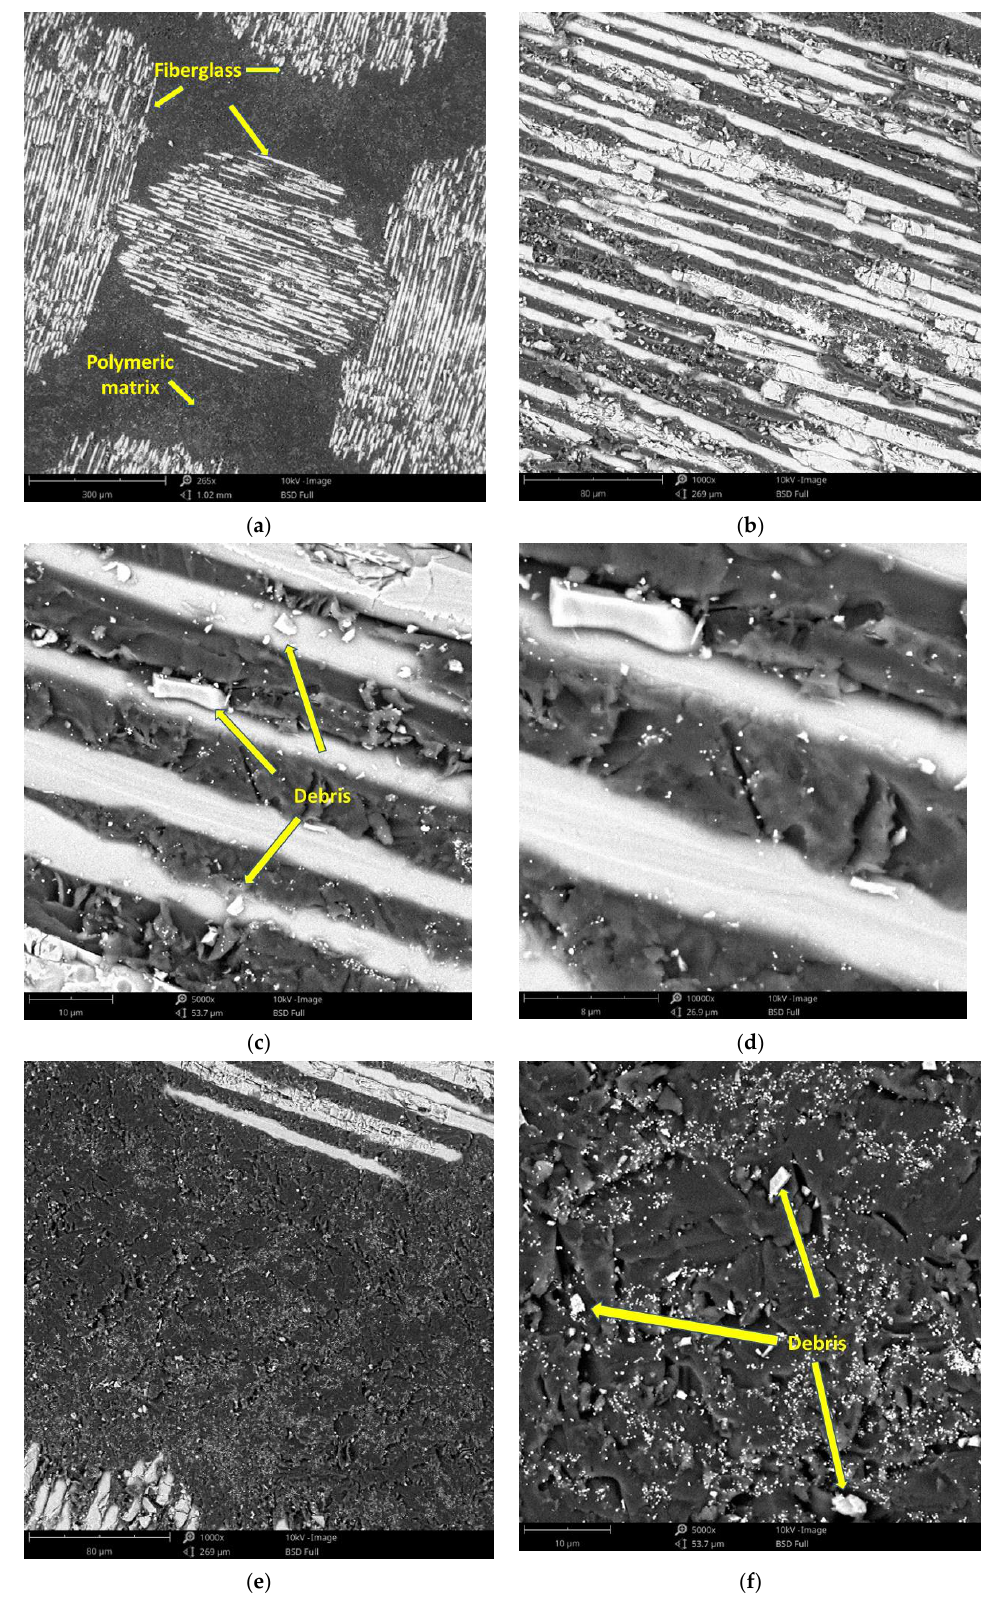
Figure 3. SEM images of C2 sample surfaces: ( a ) fiberglass at 265×; ( b ) fiberglass at 1000×; ( c ) fiberglass at 5000×; ( d ) fiberglass at 10,000×; ( e ) polymeric matrix at 1000×; ( f ) polymeric matrix at 5000×.